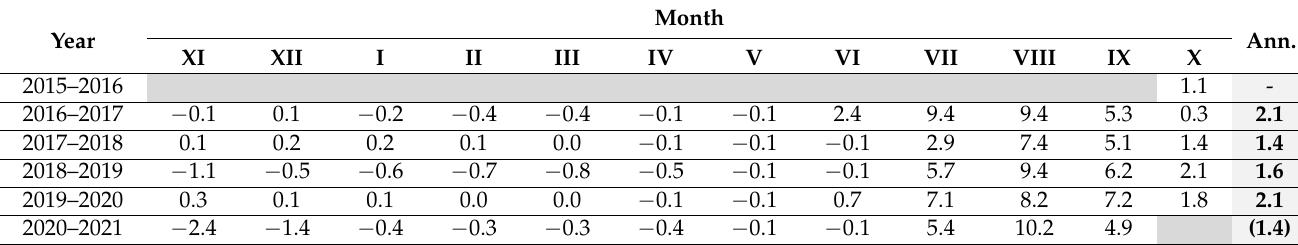
Table 7. AMean monthly temperatures at Snezhnika glacieret.